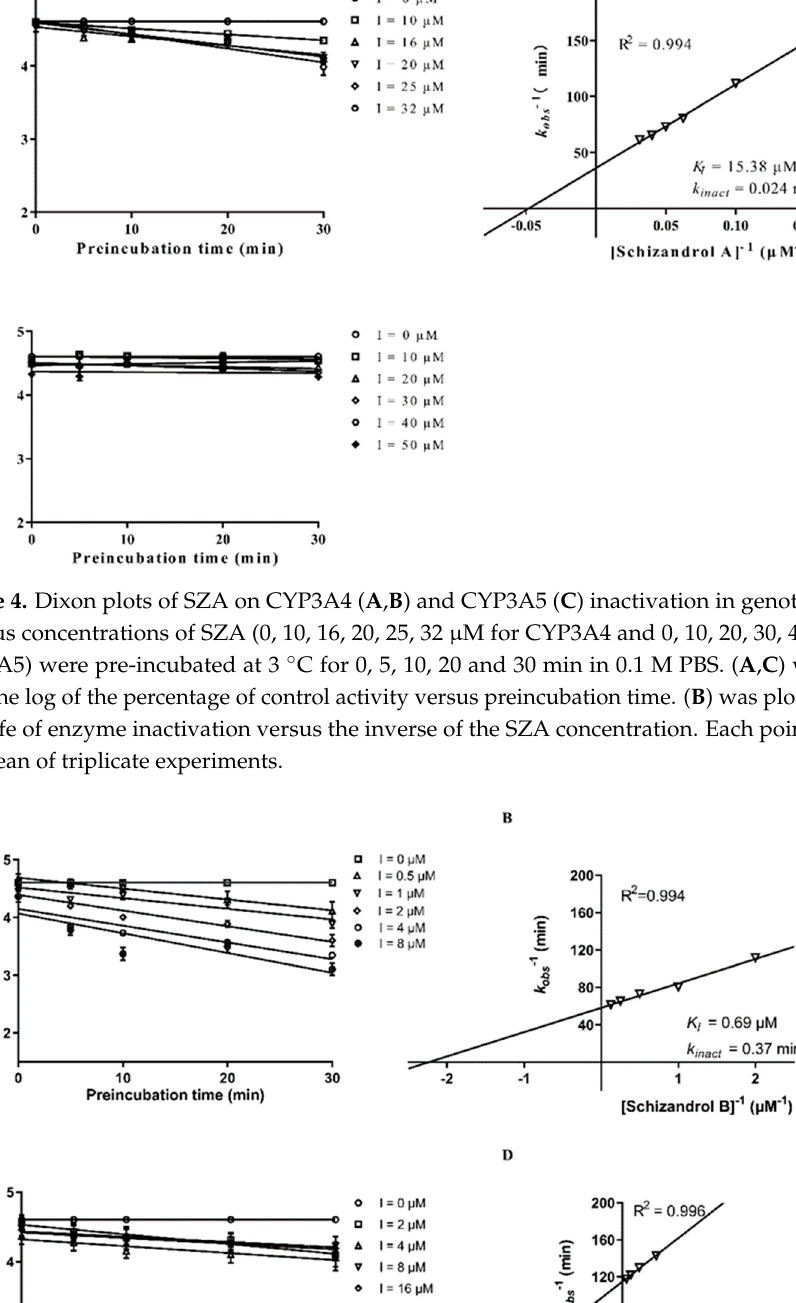
Figure 3. Dixon plots of SZA ( A , B ) and SZB ( C , D ) on CYP3A inactivation in pooled HLMs. Various concentrations of SZA (0, 10, 16, 20, 25, 32 μ M) and SZB (0, 0.1, 0.2, 0.5, 1, 2 μ M) were pre-incubated at 37 °C for 0, 5, 10, 20 and 30 min in 0.1 M PBS. ( A , C ) were plotted with the log of percentages of control activity versus preincubation time. ( B , D ) were plotted with the half-life of enzyme inactiva- tion versus the inverse of the SZA or SZB concentration. Each point represents the mean of triplicate experiments.